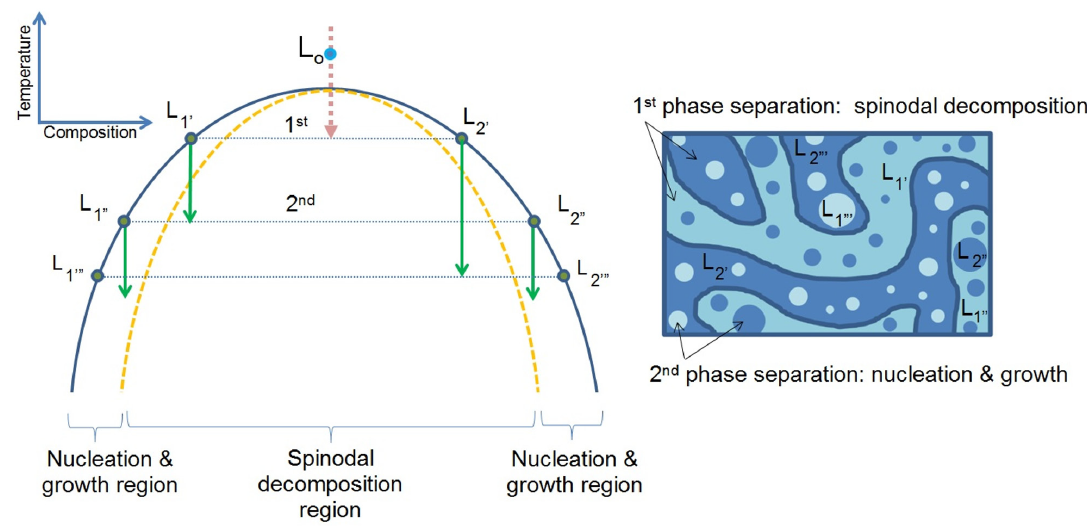
Figure 6. Schematic diagram showing multi-step phase separation sequence and interconnected structure with internal droplets.